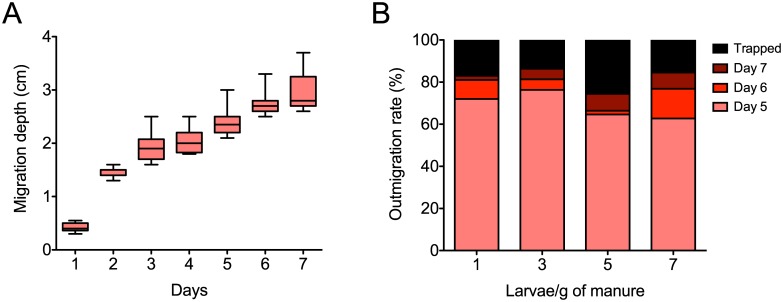
Relationship between density and migratory behavior of housefly larvae in dairy cattle manure.(A) Larva migration was observed over the 7 days of growth. Migration depth was calculated as the distance within manure (cm) that larvae were able to reach during the experiment. Data are represented as medians, 25th to 75th percentile as hinges, and range as whiskers. (B) Larvae outmigration rate was calculated as the percentage of larvae exiting or ultimately trapped in the manure environment at days 5, 6 and 7 of growth. This rate was compared across different densities of incorporation (1, 3, 5 and 7 larvae/g of fresh manure; n = 4/group).